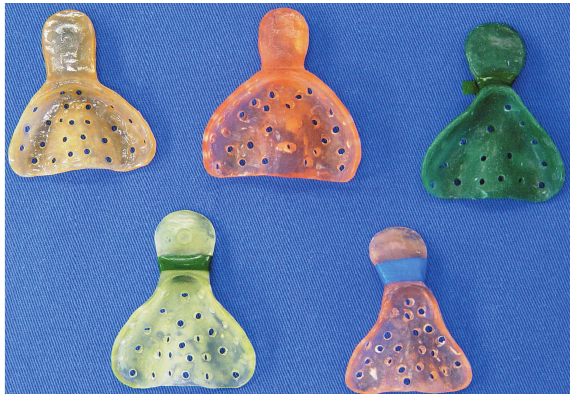
Figure 1- Customized trays constructed in acrylic resin for impressions of children at first